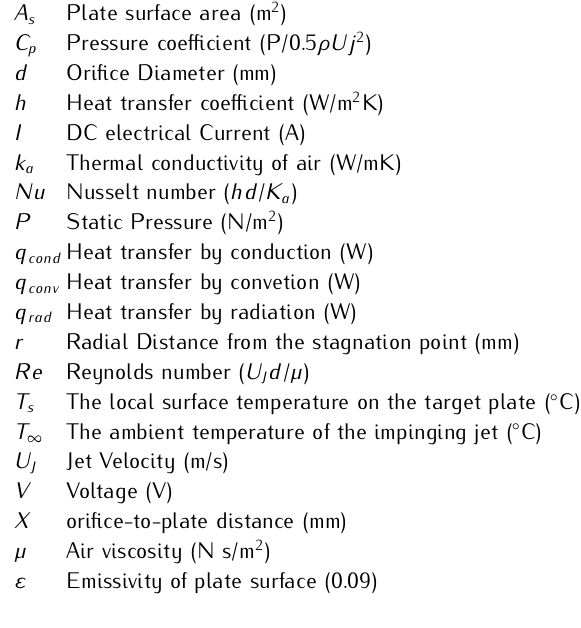
surface. The main conclusions from the present work